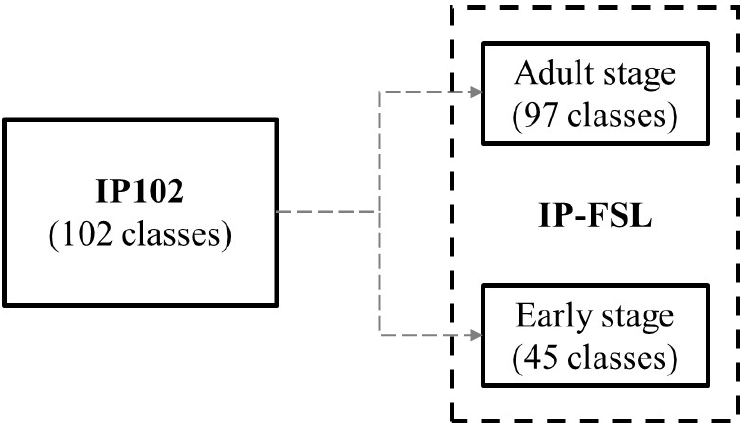
Figure 2. IP-FSL classes as derived and separated from IP102.